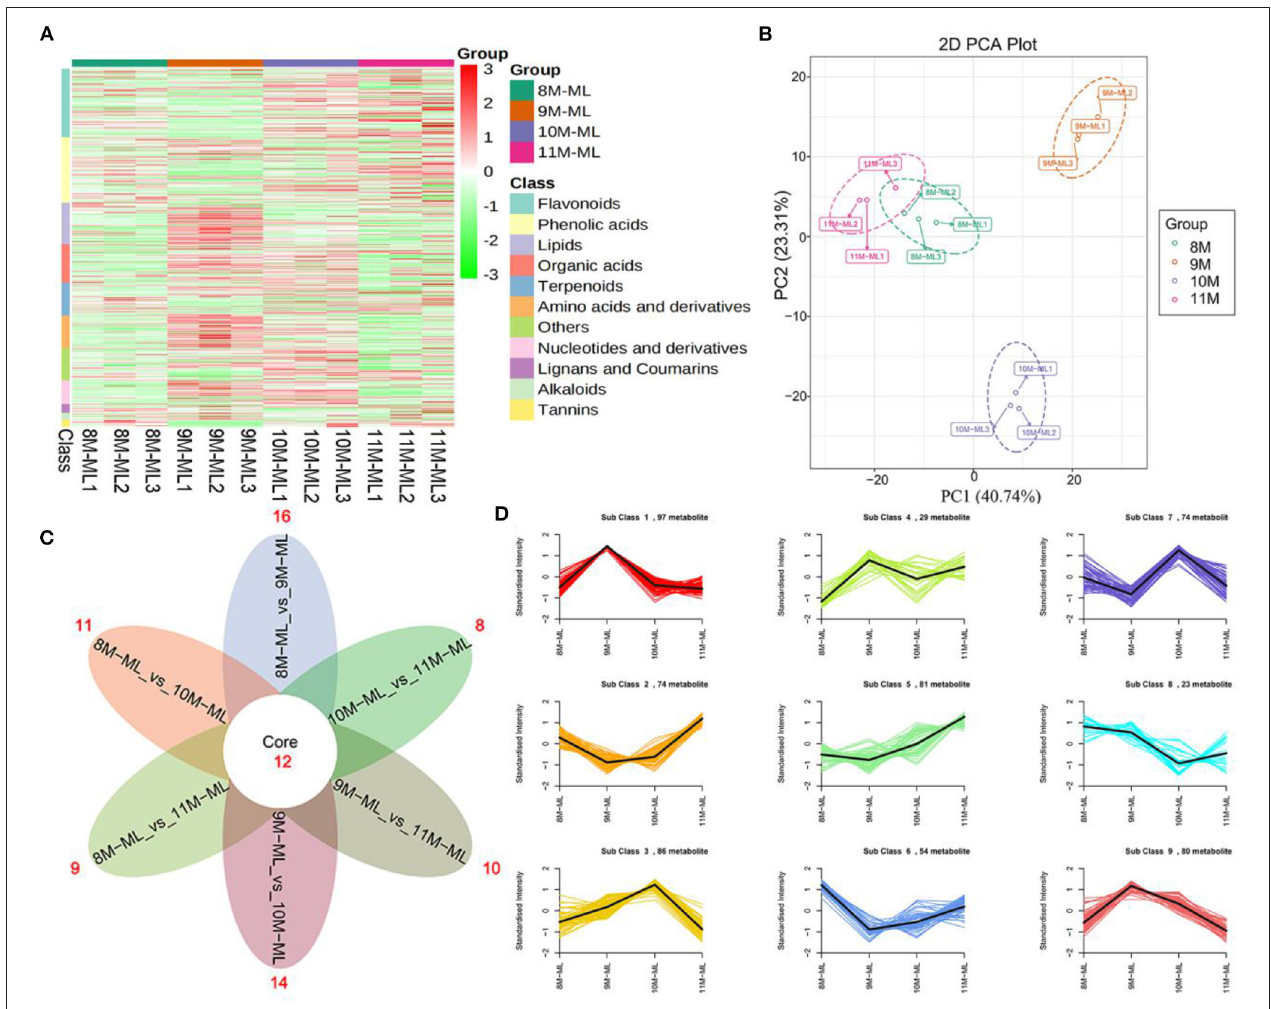
FIGURE 2 | Metabolome profiles of C. paliurus leaves from different harvest times. (A) HCA of metabolites in 8–11M. (B) PCA of 8–11M. (C) Venn diagram of DAMs among 8M_vs_9M, 8M_vs_10M, 8M_vs_11M, 9M_vs_10M, 9M_vs_11M, and 10M_vs_11M. (D) K-means analysis of DAM C. paliurus leaves from different harvest